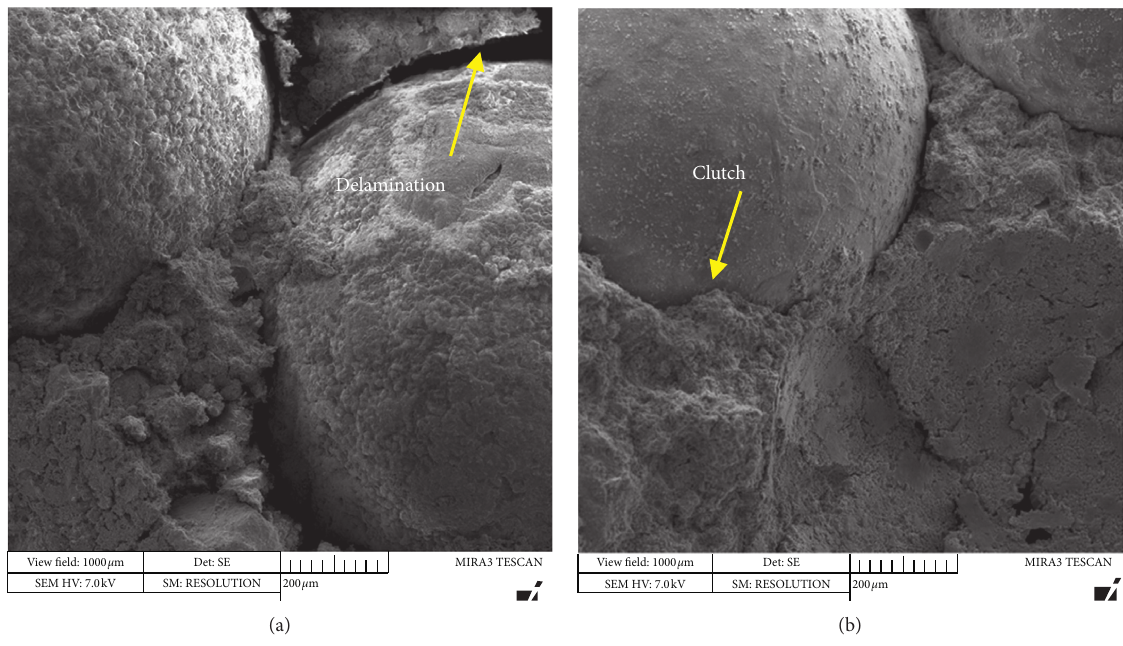
Figure 9: Surface microstructure (SEM) of a fracture of a cement composite chip based on unmodified (a) and modified (b) shot of titanium hydride subjected to c -irradiation, at a dose D � 10MGy.